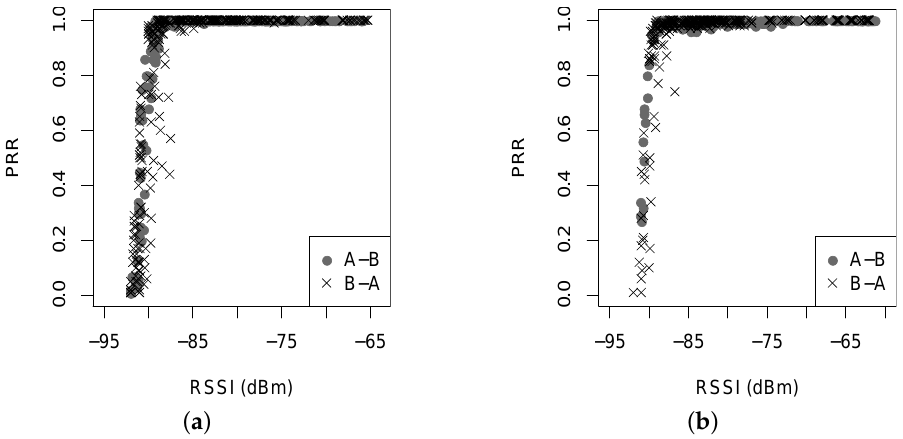
Figure 10. The PRR versus RSSI under two different forest environments. ( a ) Bajia; ( b )